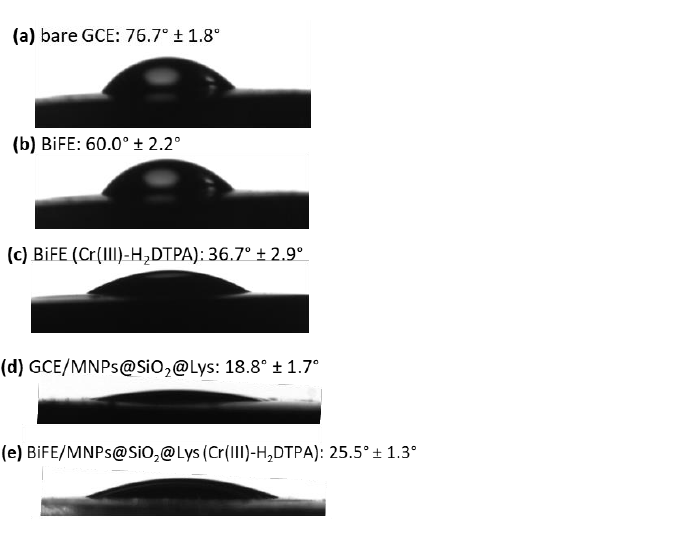
Figure 6. The shape of a drop of ultrapure water on the surface of different electrodes and the cor- corresponding contact responding contact angles.